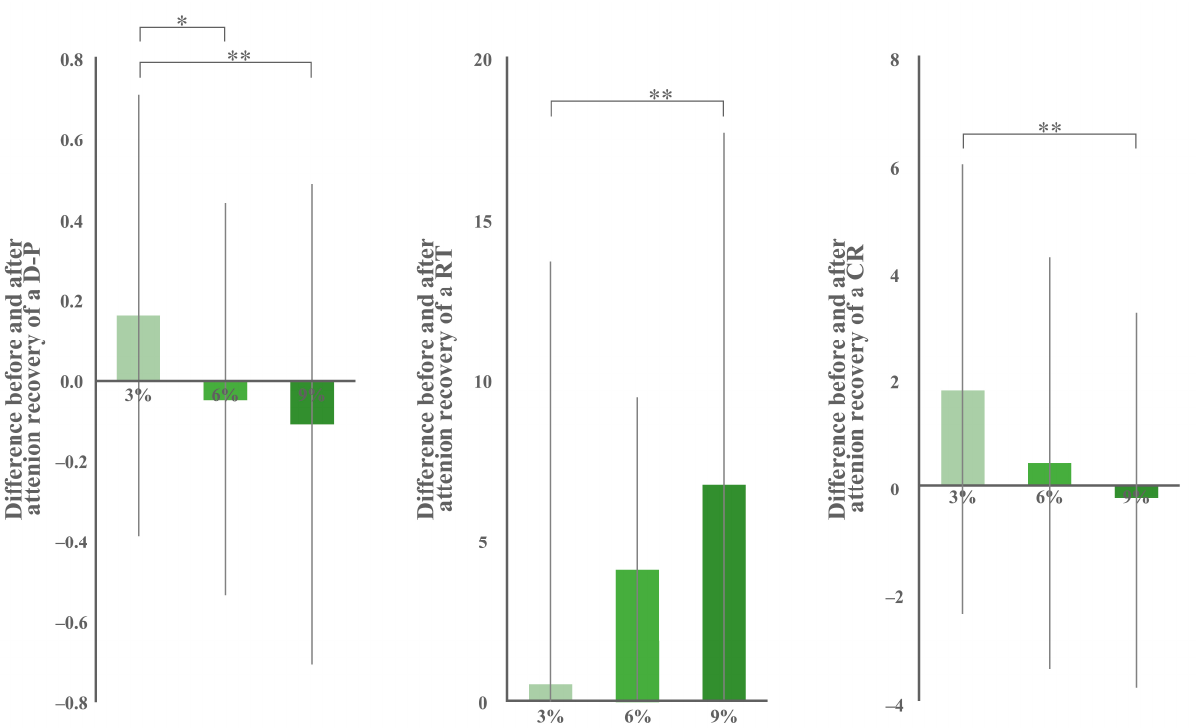
Figure 10. Main effect maps of the volume ratio of indoor plants on attention recovery. ** Stands for statistical significance at the 0.01 level; * Stands for statistical significance at the 0.05 level; Not marked stands for no statistical significance.